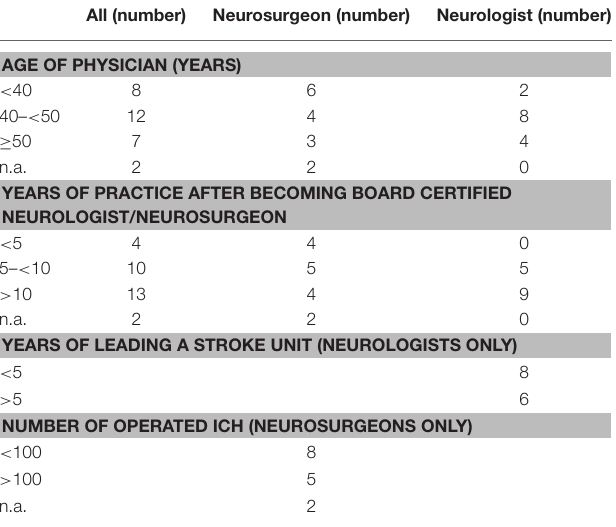
TABLE 3 | Age and years of experience of board-certified neurologists and neurosurgeons and years of supervision of a stroke unit (neurologists only) or the number of operated ICH (neurosurgeons